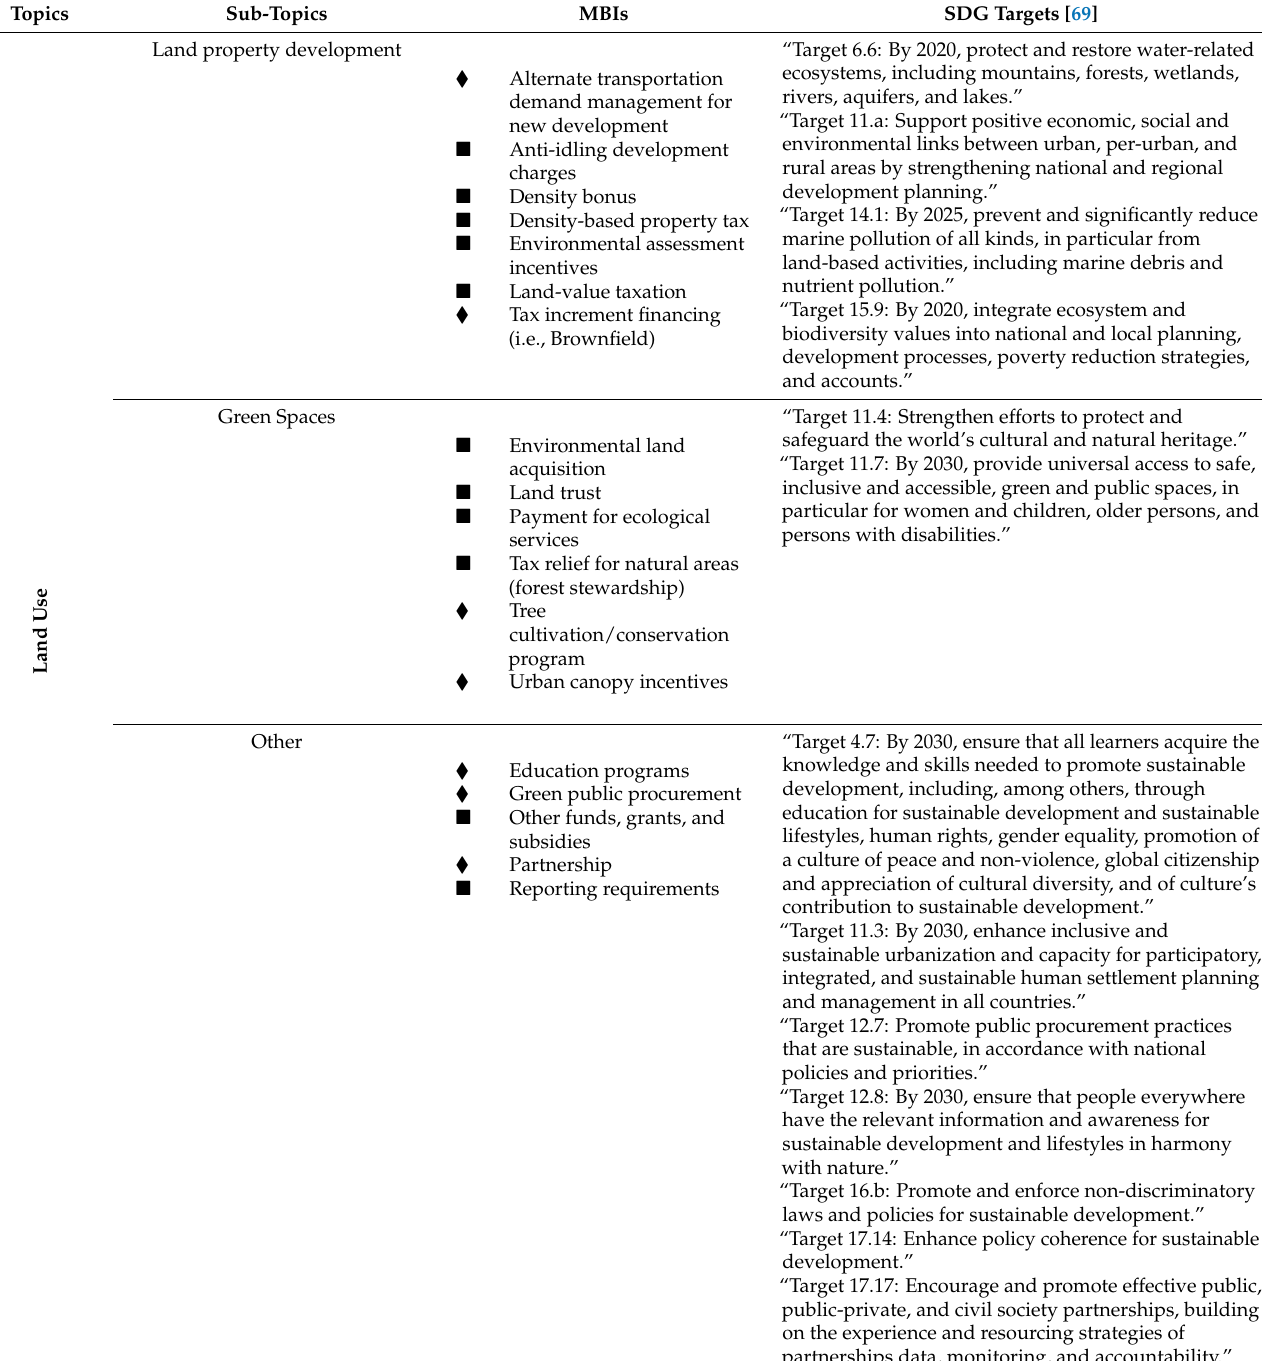
Table 7. Categorization of MBIs for Land Use and Related SDG